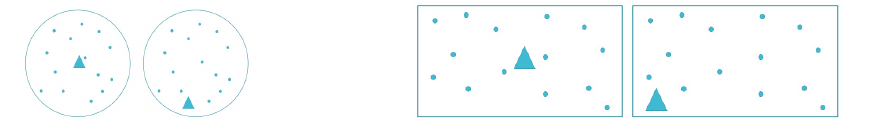
Figure 2. Circular and rectangular region with different depot locations.